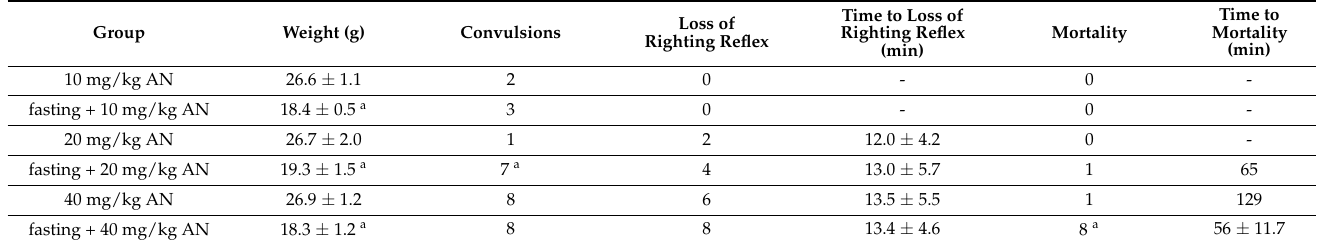
Table 1. Effect of fasting on acute toxicity in mice exposed to different doses of AN.